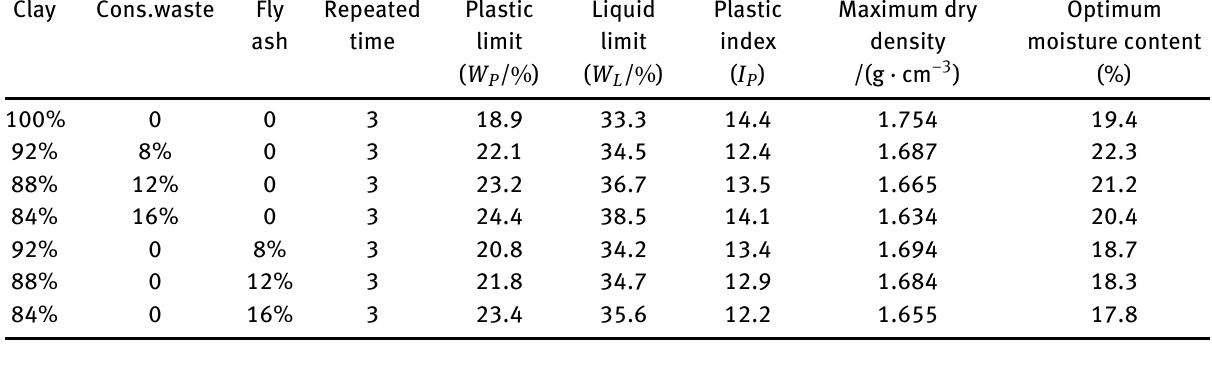
Table 6: Arrangement of test and part of test result (all values are average for 3 parallel tests). Clay